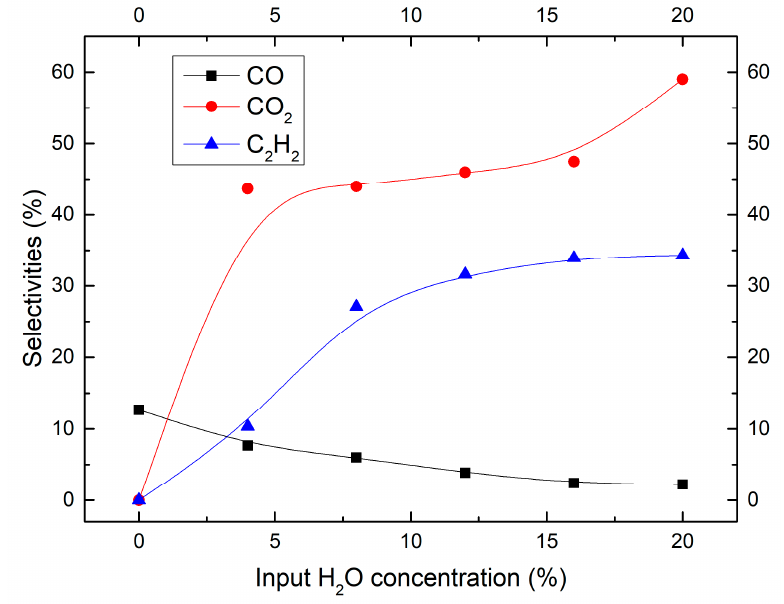
Figure 7. Effect of moisture concentration on the selectivity of CO, CO 2 , C 2 H 2 .